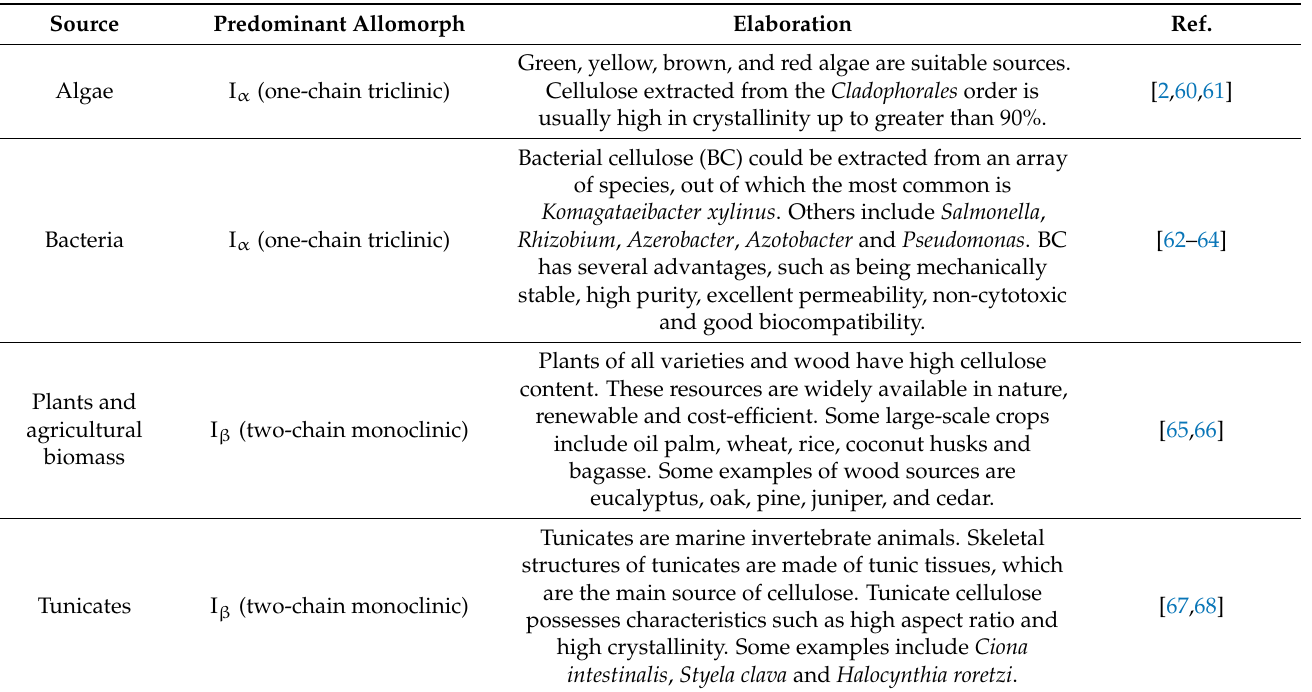
Table 2. General sources of